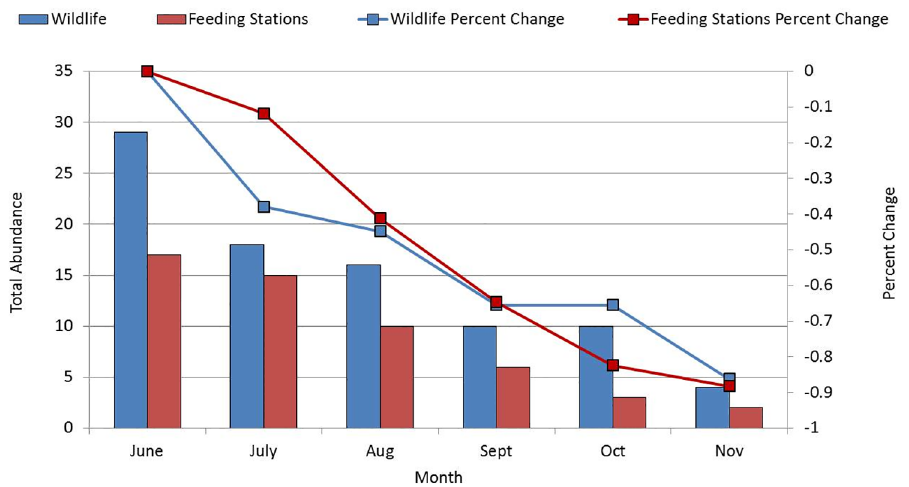
Fig 2. Abundance of outdoor wildlife and outdoor feeding sources from Jun to Nov 2015 at the mobile home community in San Gabriel Valley, California.